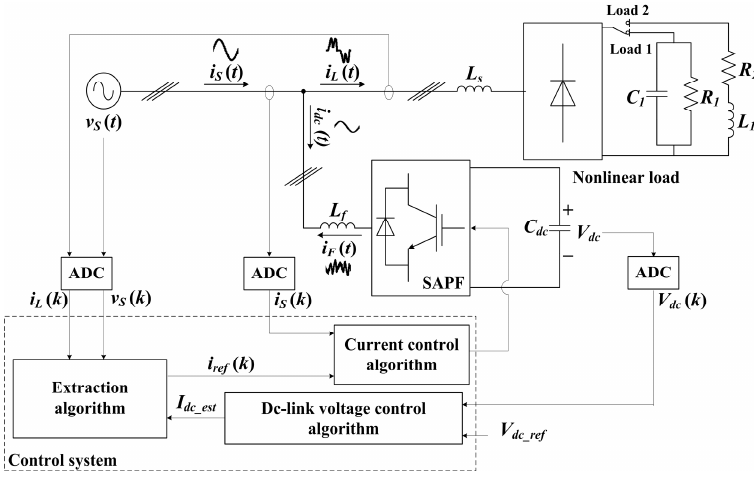
Figure 1. Control strategy for the operation of a SAPF.